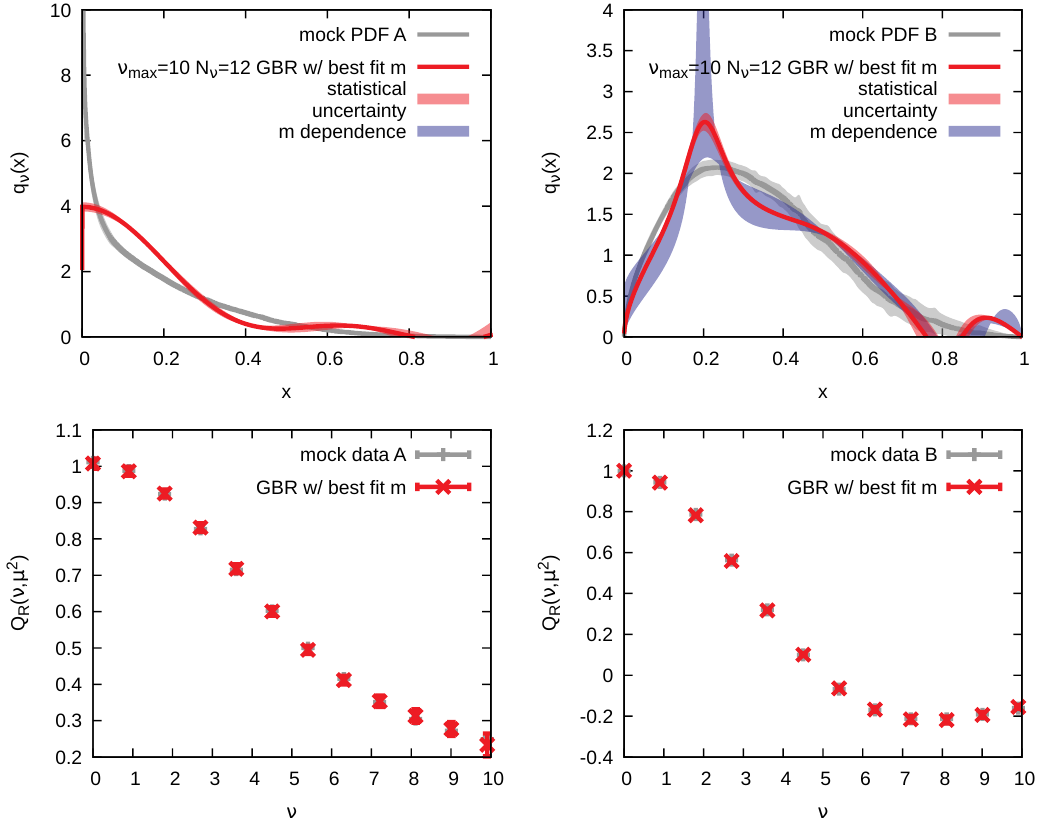
Figure 18 . x -space PDF’s reconstructed using the generalized Bayesian reconstruction (GBR) method from N (cid:23) = 12 Io(cid:11)e-time data points on the interval (cid:23) = [0 ; 10] (top) as well as the input data (gray crosses) compared to the data arising from the reconstructed PDF (red crosses) in the bottom